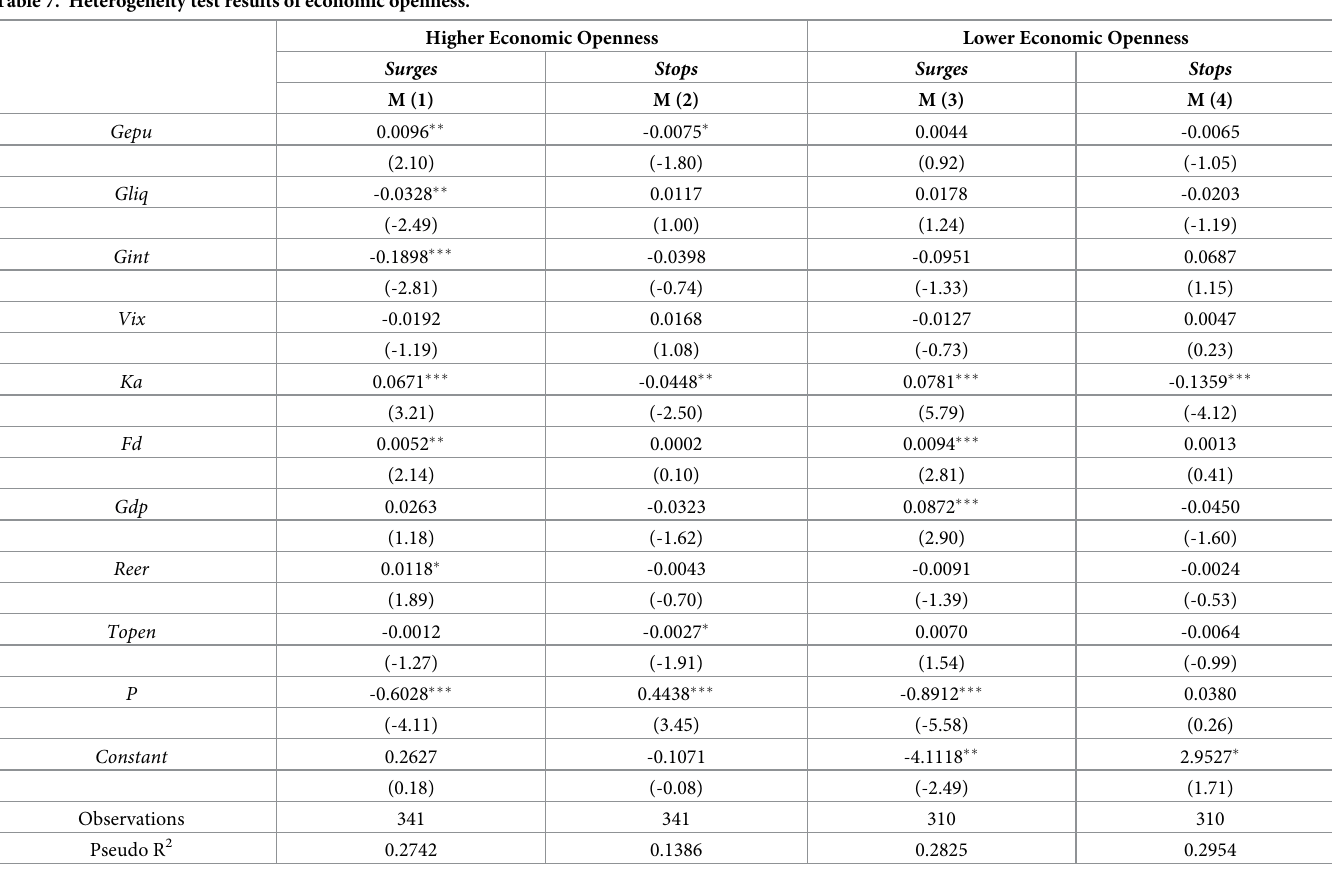
Table 7. Heterogeneity test results of economic